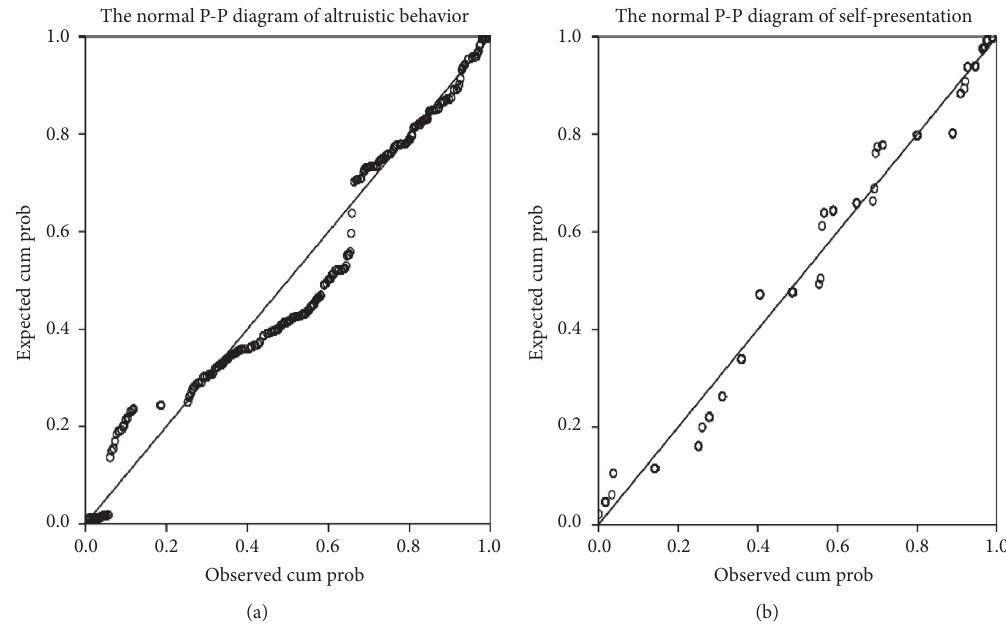
Figure 3: P-P plots of adolescent altruistic behaviors (a) and self-presentation